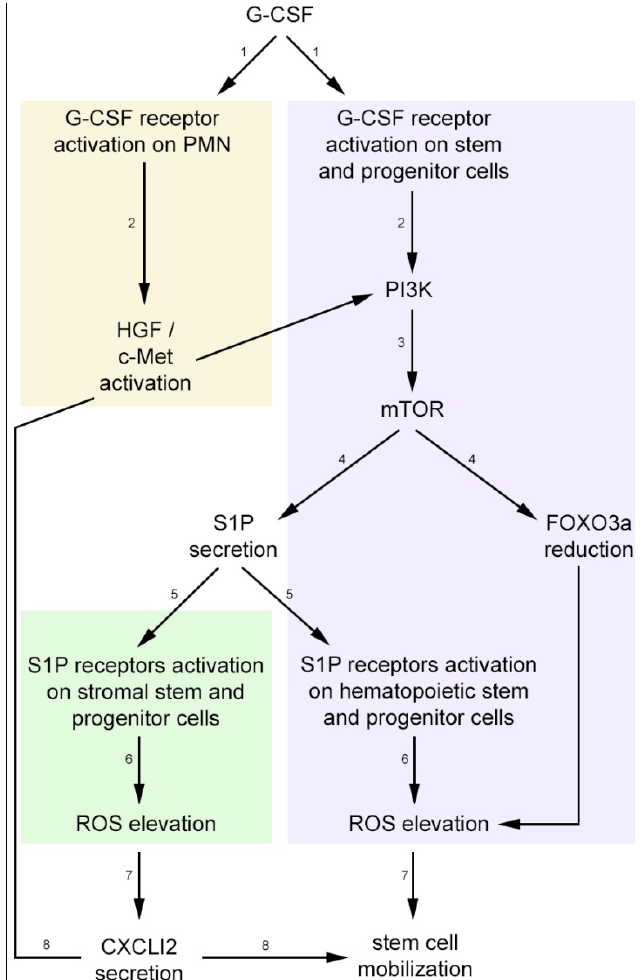
Figure 1. Flow chart of CXCL12 and S1P regulation during G-CSF-induced mobilization of stem cells. Upon G-CSF administration, it activates its receptors on stem cells and polymorphonuclear cells (PMN), activating HGF/c-Met. Such activation induces PI3K signaling via mTOR and FOXO3a reduction, leading to S1P production and secretion from BM cells [38]. S1P in turn can bind to its receptors both on stem cells thus leading to ROS generation and also on BM stromal progenitor cells to further facilitate CXCL12 secretion. CXCL12 can activate PI3K via HGF/c-Met signaling to further facilitate stem cell mobilization. The numbers in this suggested model represent the sequence of events